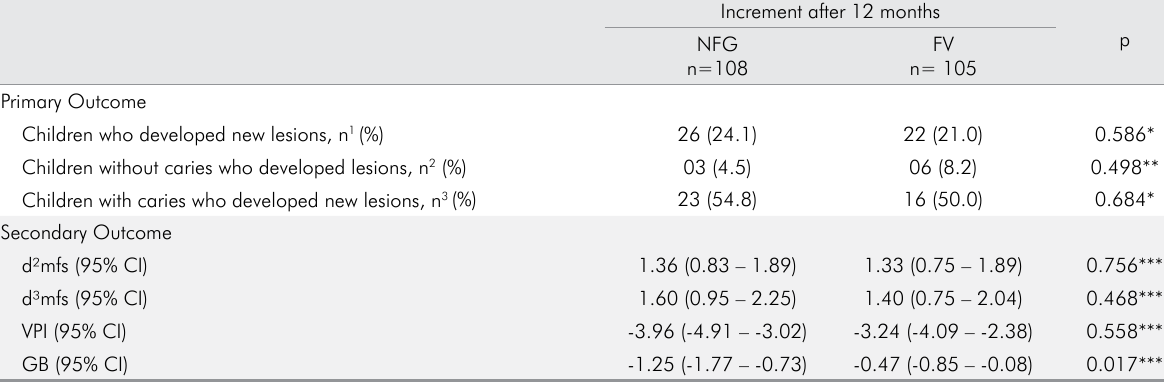
Table 4. Comparison of caries increment of NFG and FV groups at the 12-month